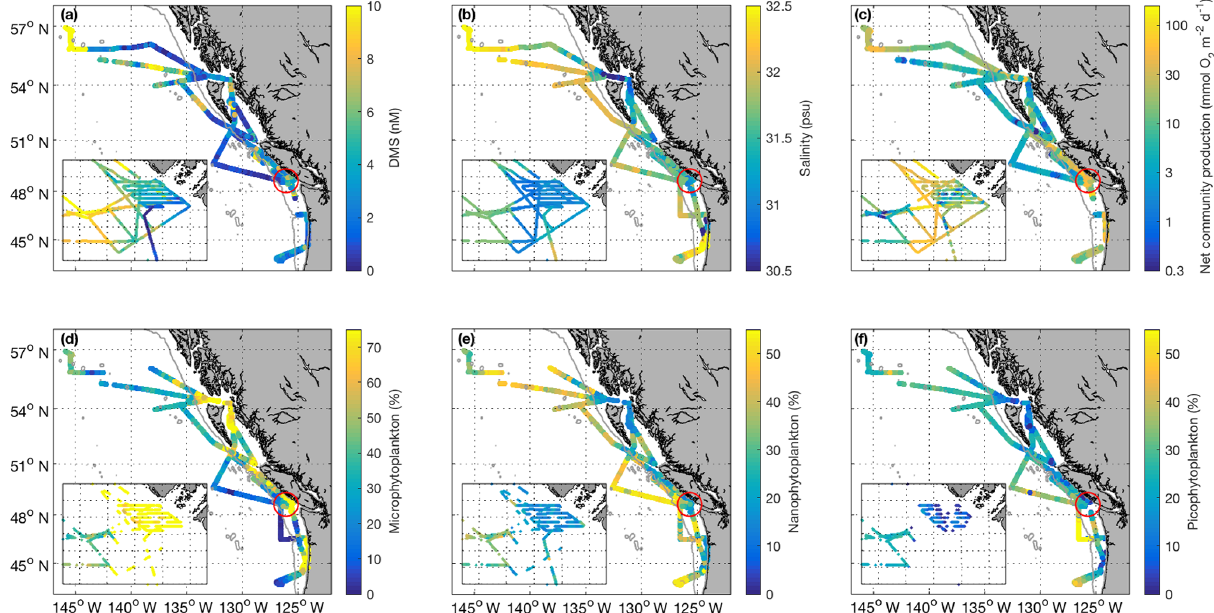
Figure 2. Spatial distribution of DMS (a) , salinity (b) , net community production ( c – log scale), and microphytoplankton, nanophytoplank- ton, and picophytoplankton relative abundance (d–f) during the O16 cruise (July 2016) and the O17 cruise (August 2017). Colour scaling on the maps is adjusted to ensure readability and best illustrate spatial patterns. Some data values are higher than the maximum scale of the colour bar. The inset box shows the La Pérouse Bank region, as marked by the red circle. The grey line represents the coastal–open ocean boundary (2000m